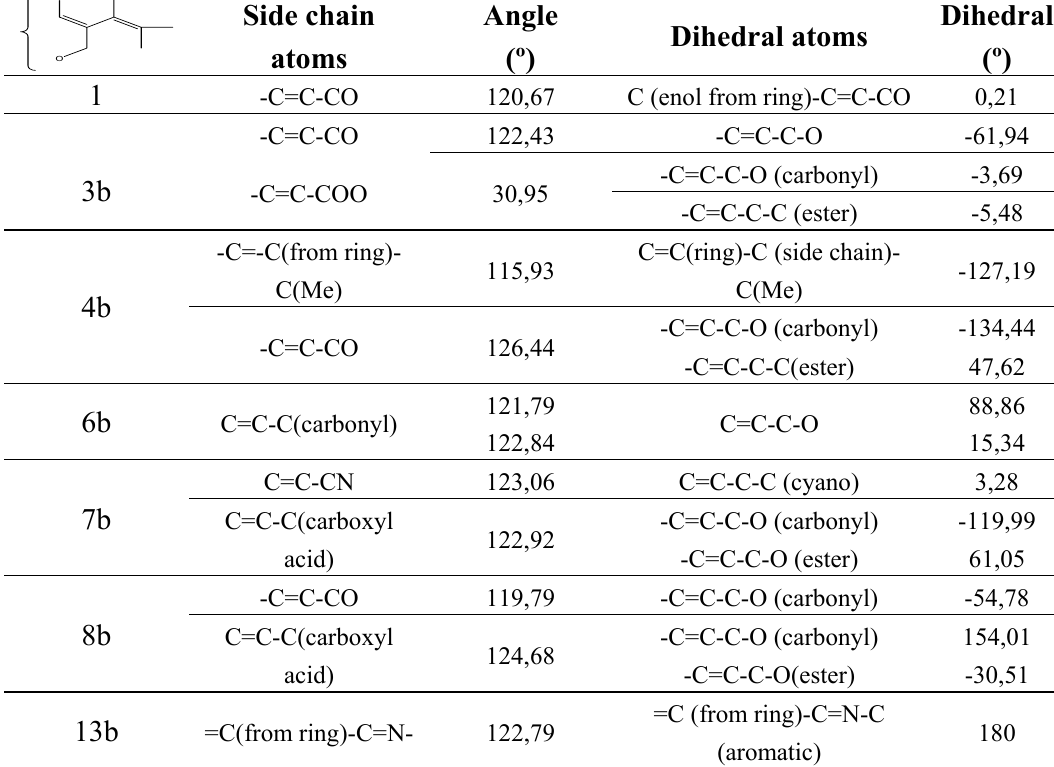
Table 3. Side chain atom angles of observed